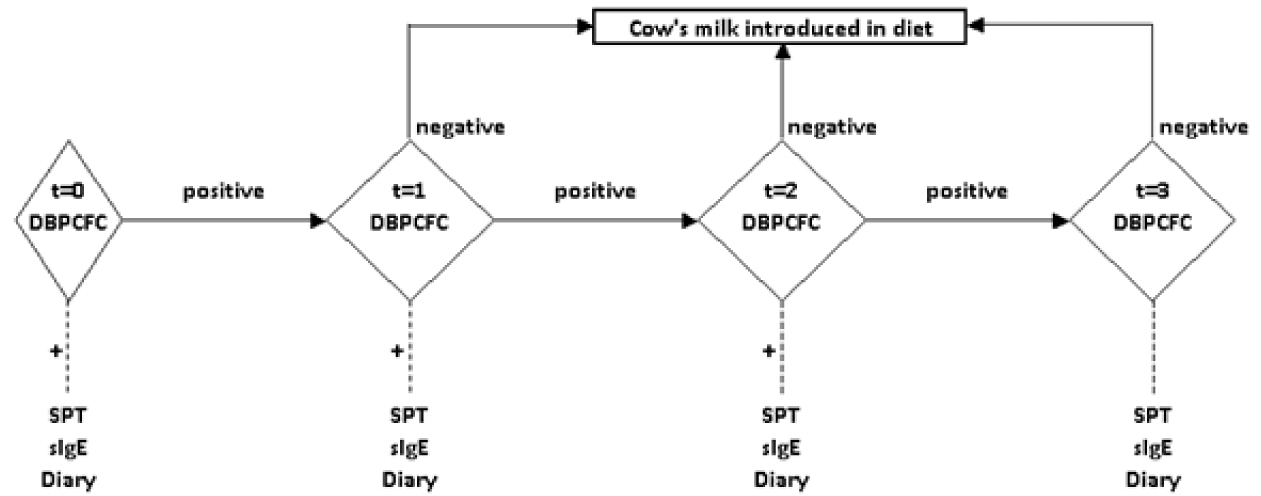
Figure 1. Flow chart iAGE study; DBPCFC: double-blind placebo-controlled food challenge; pos: positive; neg: negative; t: number of visits; SPT: skin prick test; sIgE: serum allergen-specific